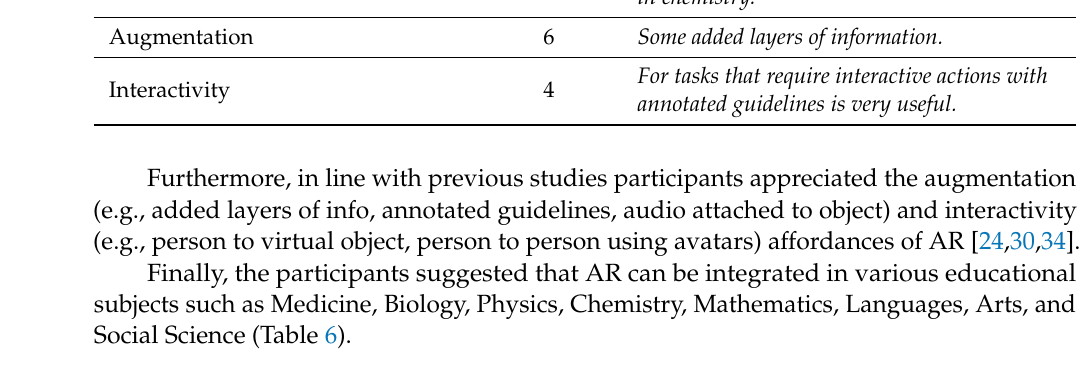
Table 6. Educational subjects (disciplines, fields) for integrating